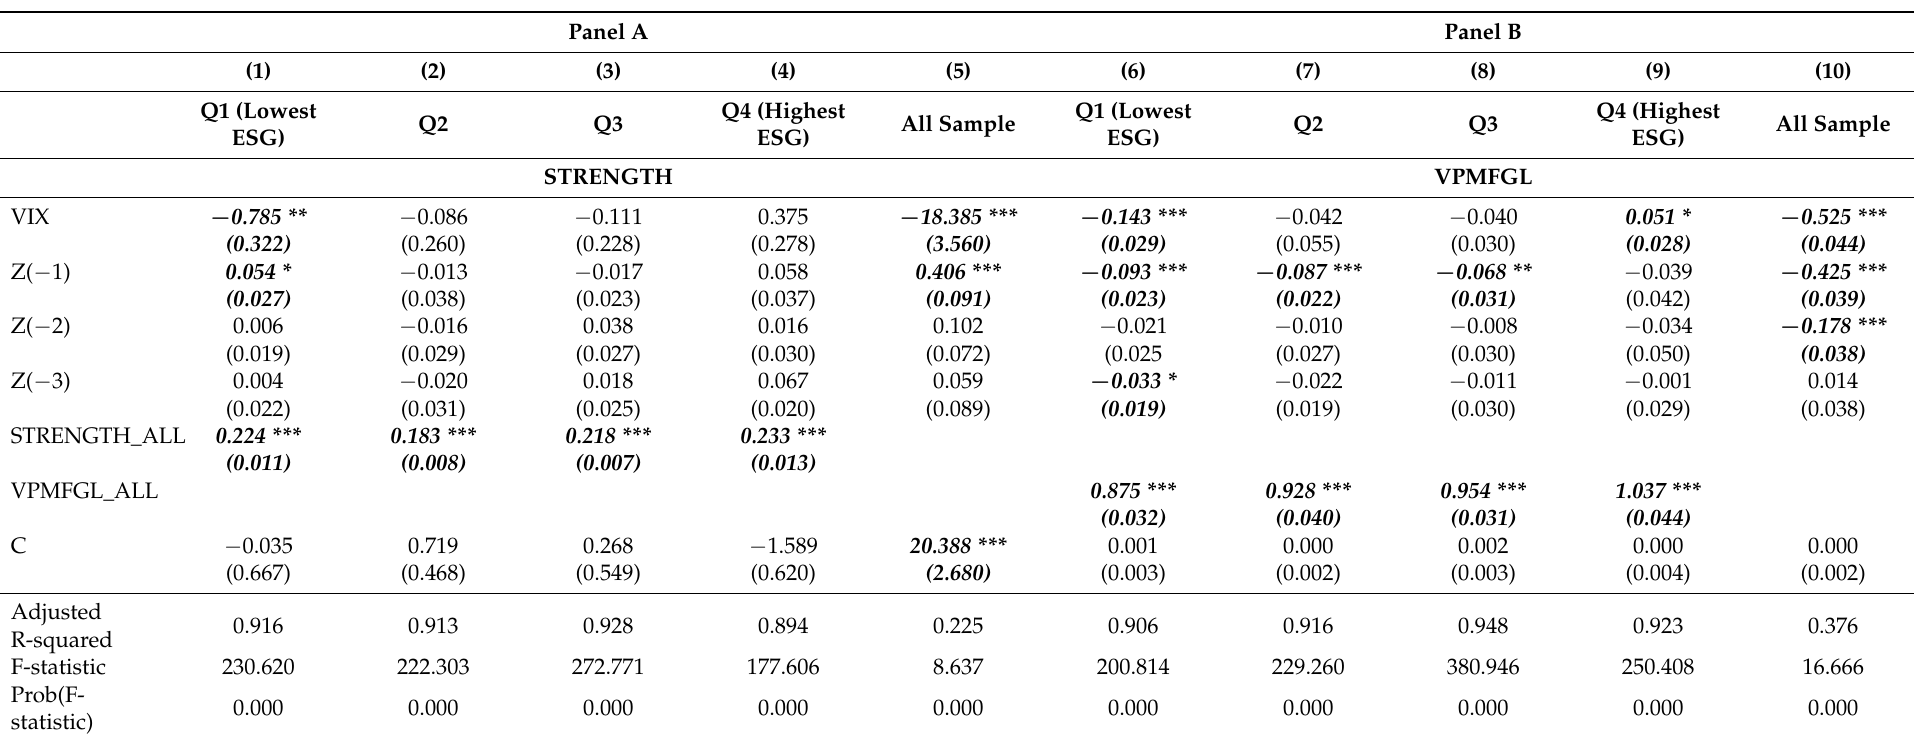
Table 3. Strength and PMFGL